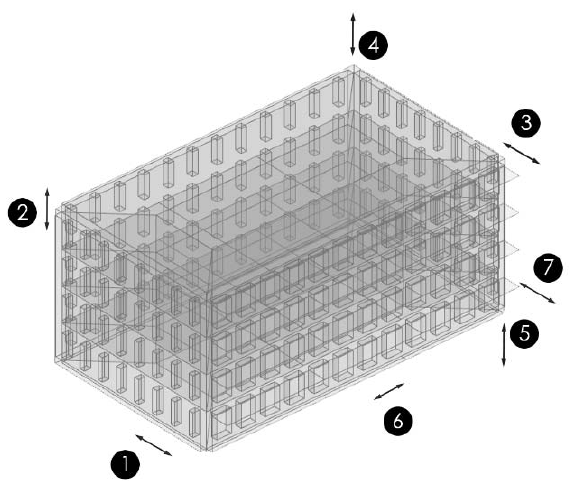
Figure 3. The parametric model used in Study 01. A total of seven parameters describe the building shape (1: width; 2: levels; 3: wall insulation thickness; 4: roof insulation thickness; 5: ground insulation thickness; 6: fenestration ratio on the southern façade; and 7: shading length).